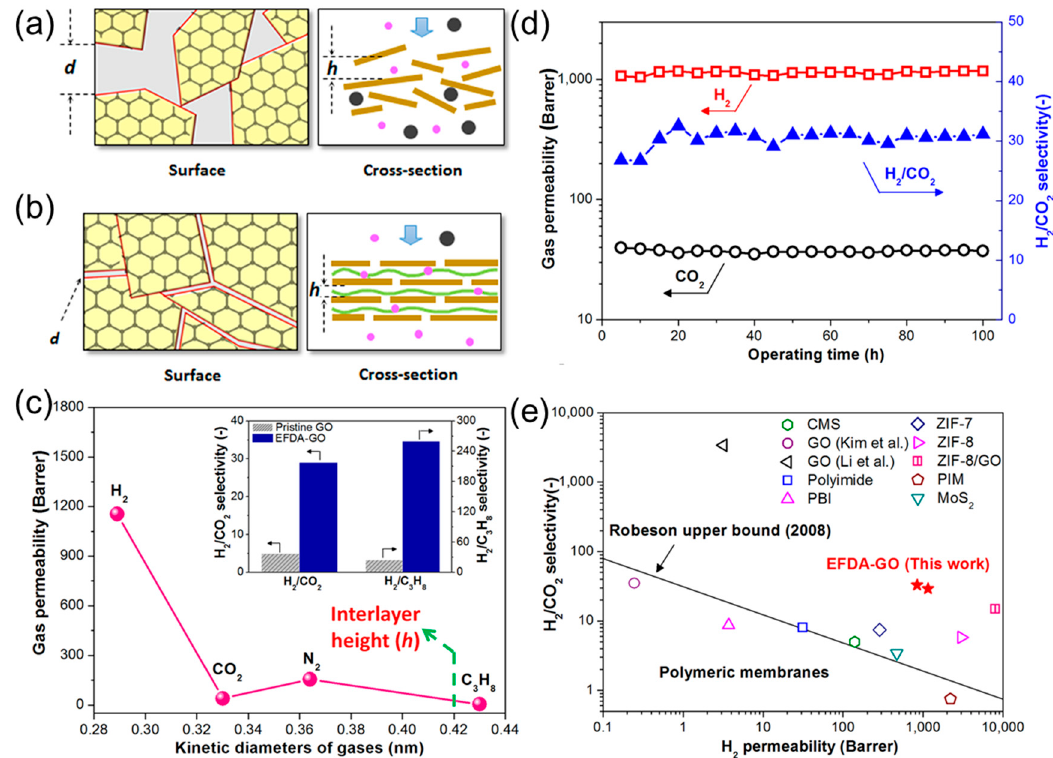
Figure 5. Schematic of GO-based 2D channels with ( a ) disordered structure and ( b ) highly ordered laminar structures. ( c ) Gas permeability of the EFDA − GO membranes. The inset compares the EFDA − GO with pristine GO membrane for H 2 /CO 2 and H 2 /C 3 H 8 selectivity. ( d ) Long-term H 2 /CO 2 separation performance of the EFDA − GO membranes. ( e ) Comparison of the EFDA − GO membranes with the state-of-the-art materials for H 2 /CO 2 separation. Adapted with permission from [24]. American Chemical Society (2016).